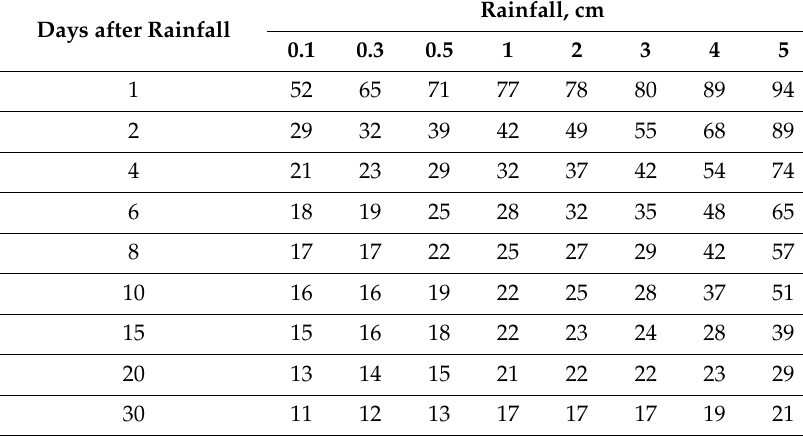
No Pixel Soil-litter moisture, %